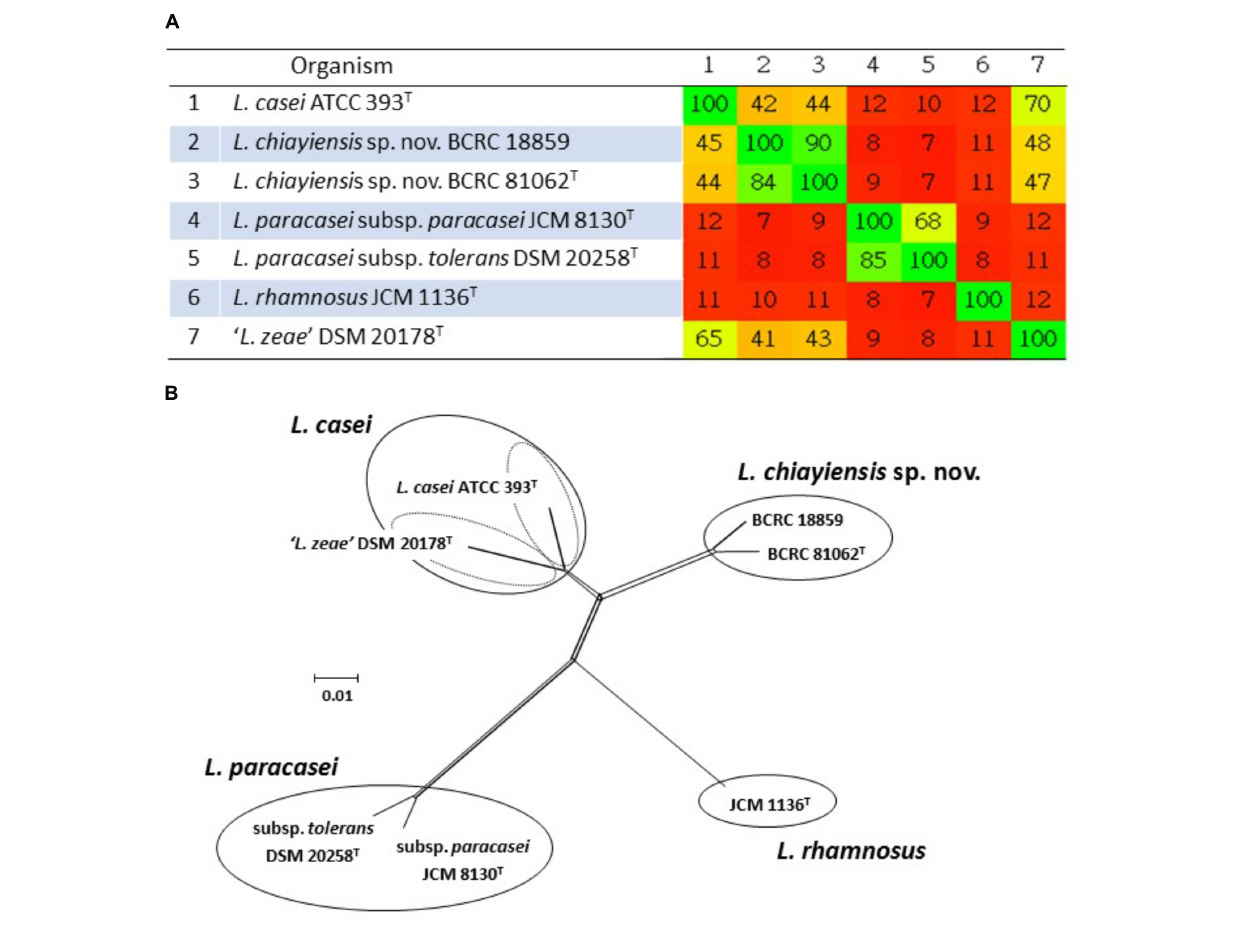
FIGURE 3 | Phylogenomic analysis of the L. casei group. The values generated in the Gegenees software shown in the heat map indicate the percentage of similarity between the analyzed genomes; the colors varies from red (low similarity) to green (high similarity) (A) . The split network tree was constructed using the SplitTree4 program based on the fragmented all-against-all comparison with the Gegenees software (B)